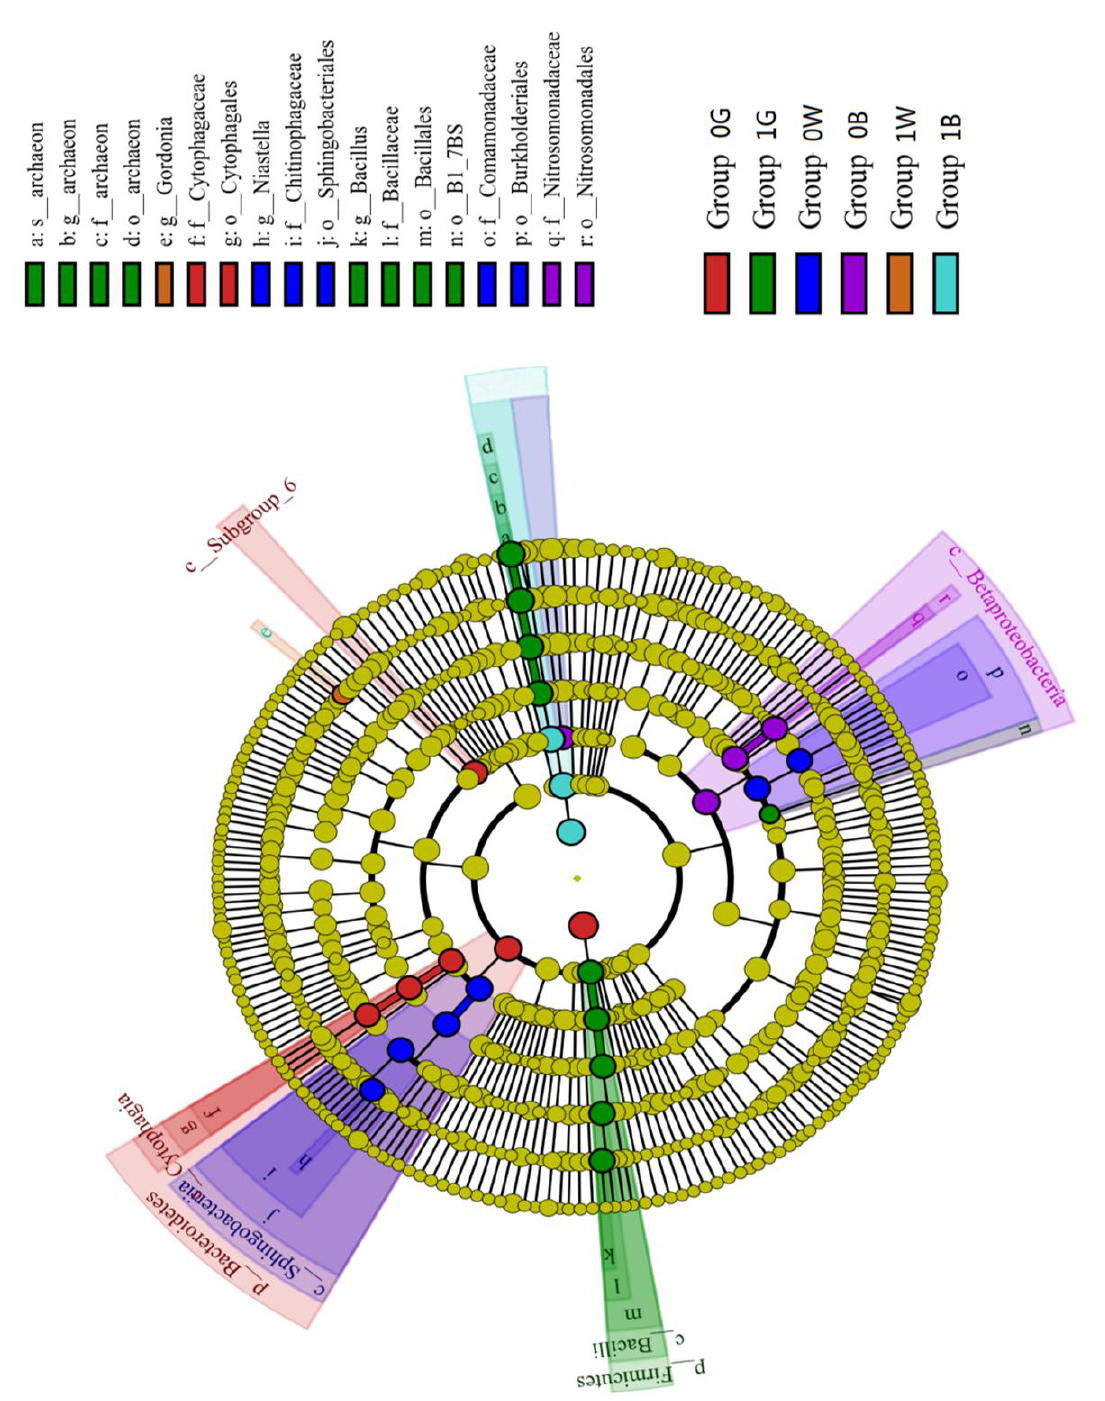
Figure 4. LEfSe analysis of evolutionary branching graphs. The circle of evolutionary branching maps from internal to external radiation represents the classification level from the phyla to the species; the principle of coloring is that the species with no significant differences are colored yellow, and the other species are colored according to the group with the highest abundance of the species; Groups 0 and 1: the reclamation in Weihe Terrace soil and silty loam in Loess tableland, respectively; Groups B, G and W: the reclamation plants of Agropyron cristatum (L.) Gaertn, Cynodon dactylon Linn. Pers. and undisturbed plants.